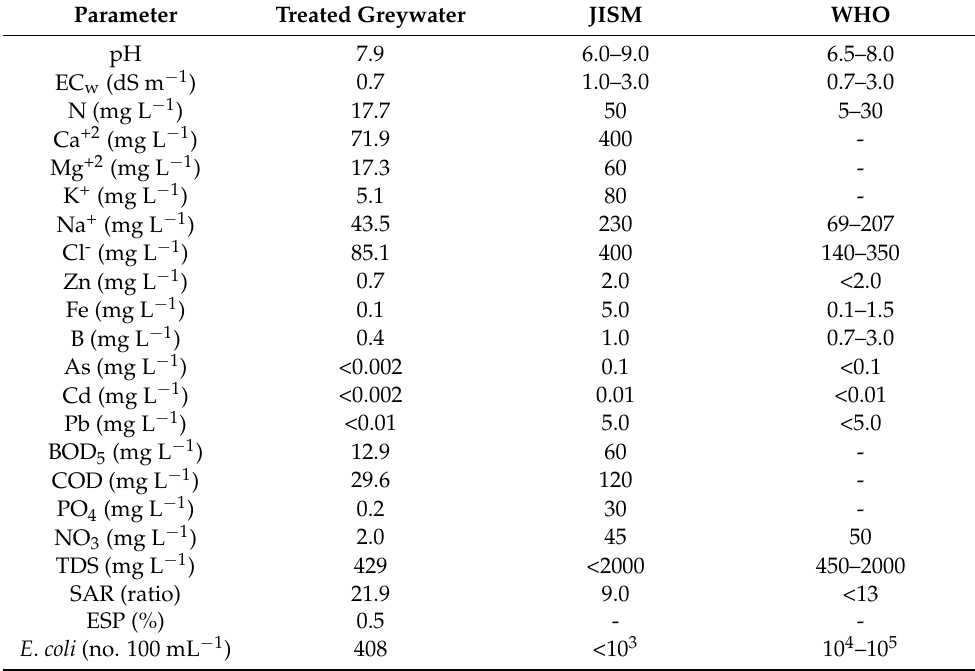
Table 1. Quality of treated greywater compared with allowable Jordanian standard limit for irri- gation (Jordan Institution for Standard and Metrology (JISM)) and the World Health Organization (WHO)